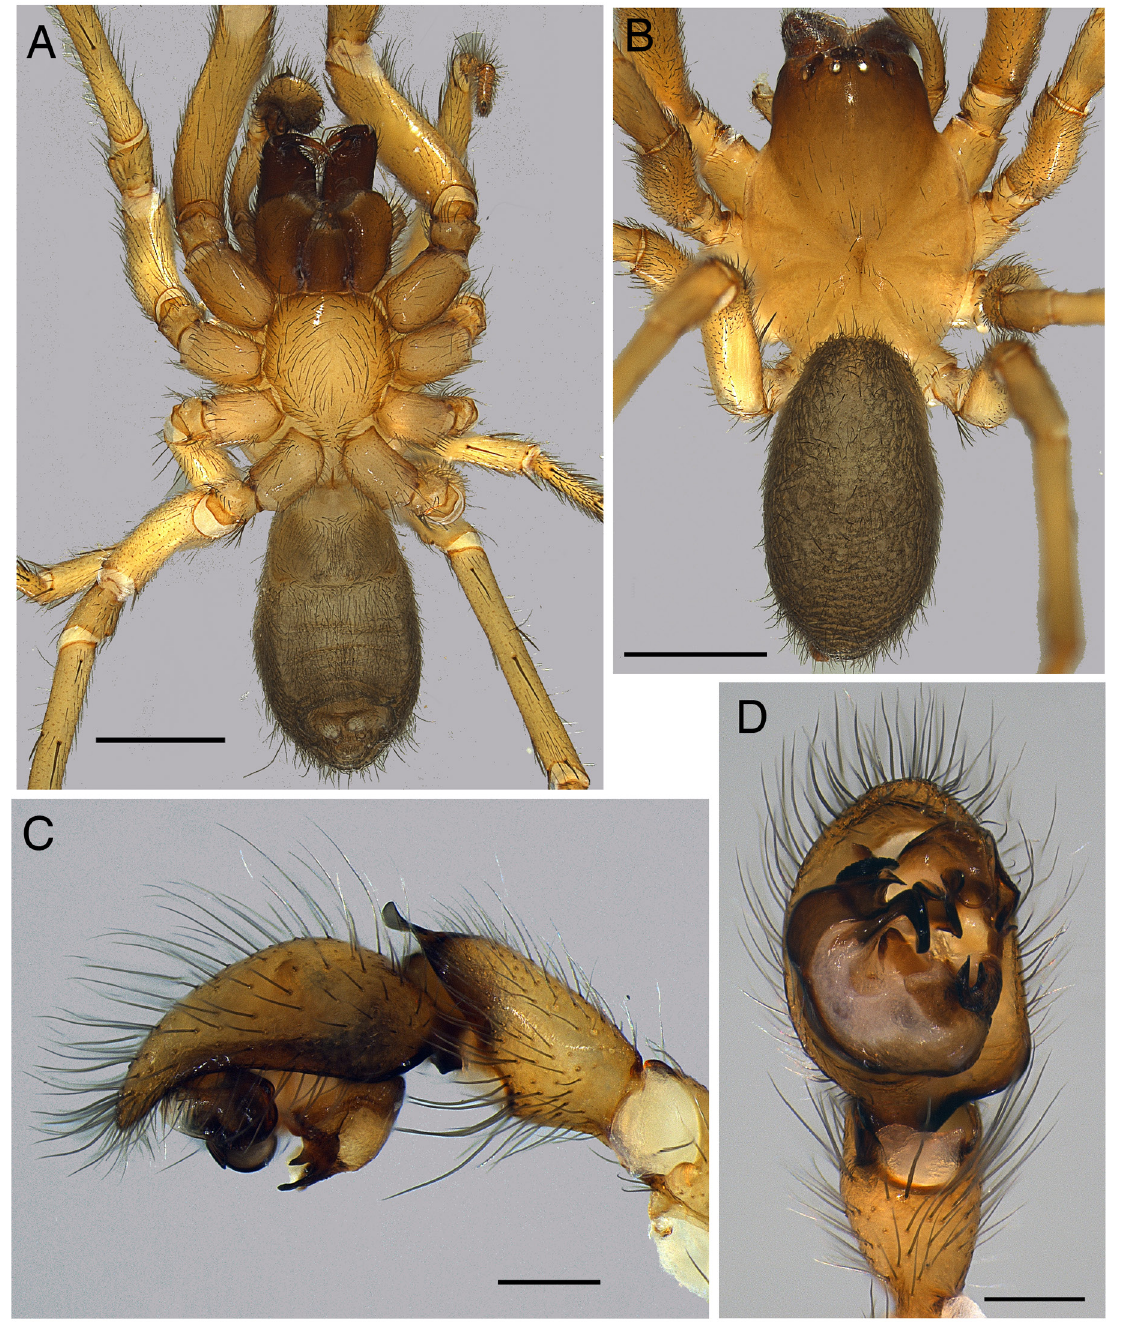
Fig. 1. Xevioso cepfi sp. nov., holotype, ♂ (RMCA_ARA_245493). A . Habitus, ventral view. B . Habitus, dorsal view. C . Palp, retrolateral view. D . Palp, ventral view. Scale bars: A–B = 1 mm; C–D = 200